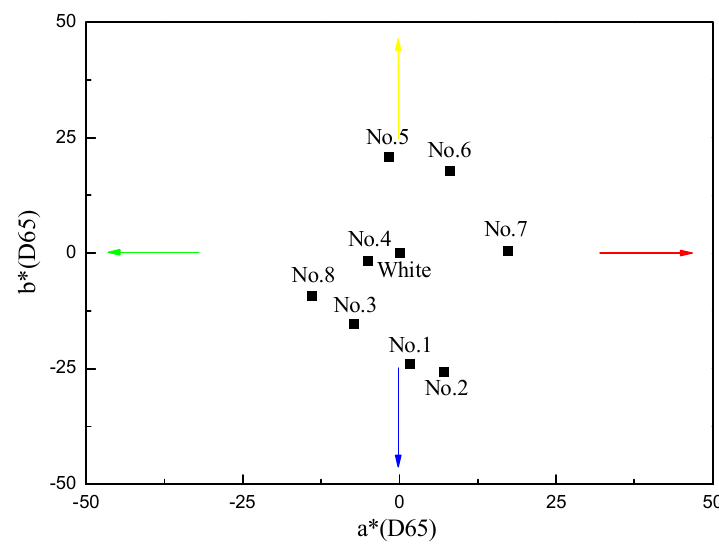
Figure 5. Distribution of chromaticity indices, a* and b*, for the samples coated with Al/TiO 2 composite films.